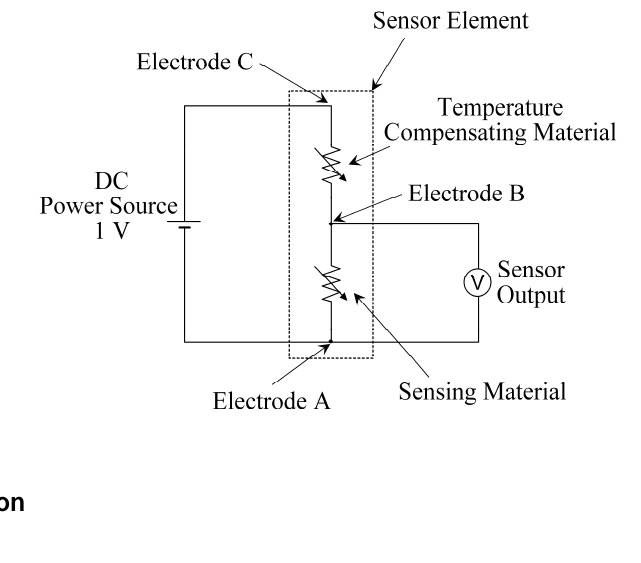
Figure 1. Electrical circuit for the sensor element using the temperature compensating